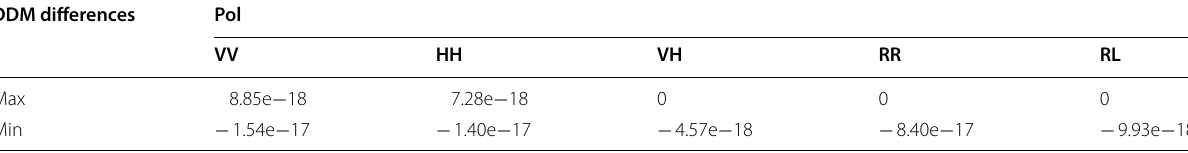
Table 3 Maximum and minimum BRCS differences at linear and circular